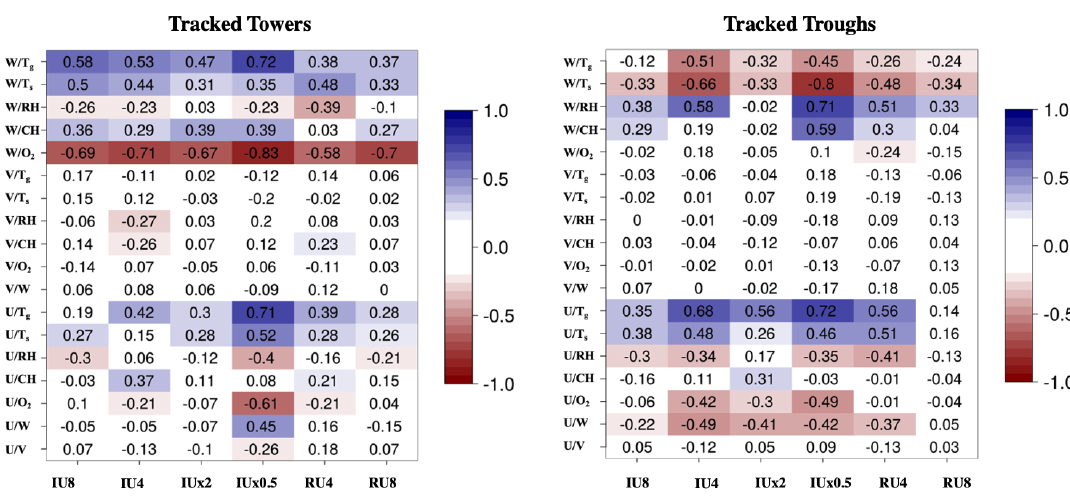
Figure 3. ( Left ) Correlation coefficient between different flow quantities associated with untracked or stationary towers. The y axis shows the two fluctuating quantities (separated by /) between which the correlation coefficients are computed. U , V , W indicate the longitudinal, cross-stream and vertical wind velocities, T g indicates gas temperature, T S indicates solid or fuel temperature, RH denotes radiative heating, CH indicates convective heating, O 2 denotes oxygen concentration. On the x axis, the different simulation cases are shown. A colormap is used to highlight the correlation coefficient magnitude for ease of comparison. ( Right ) Same as the left panel but for untracked or stationary troughs.